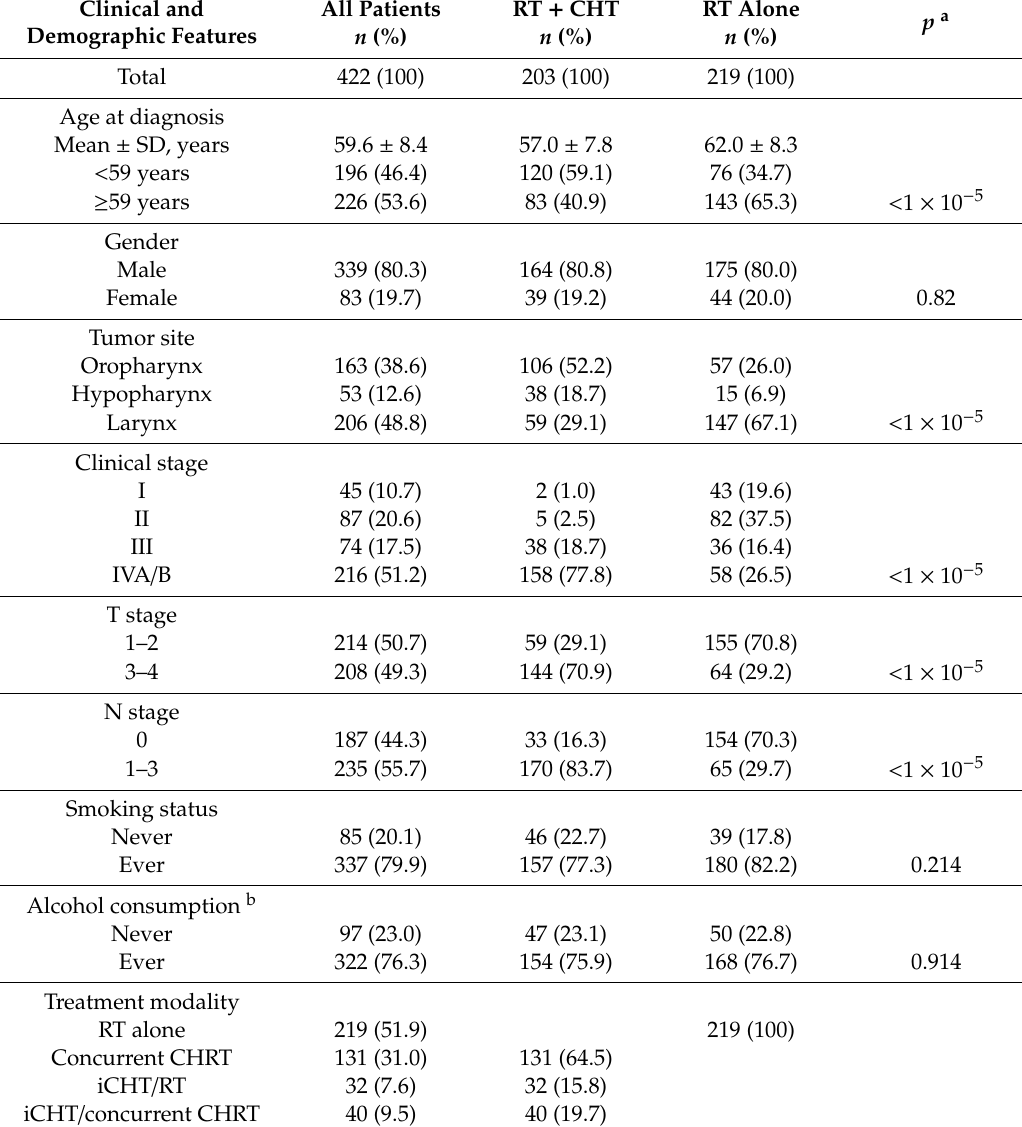
Table 1. Characteristics of the